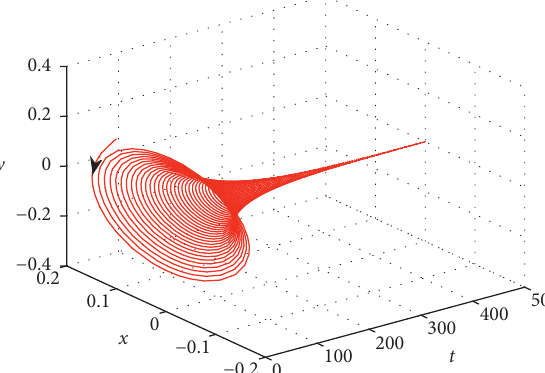
Figure 3: State trajectory of system (7) near ( d tspan � [ 0 , 500 ] , and ( x